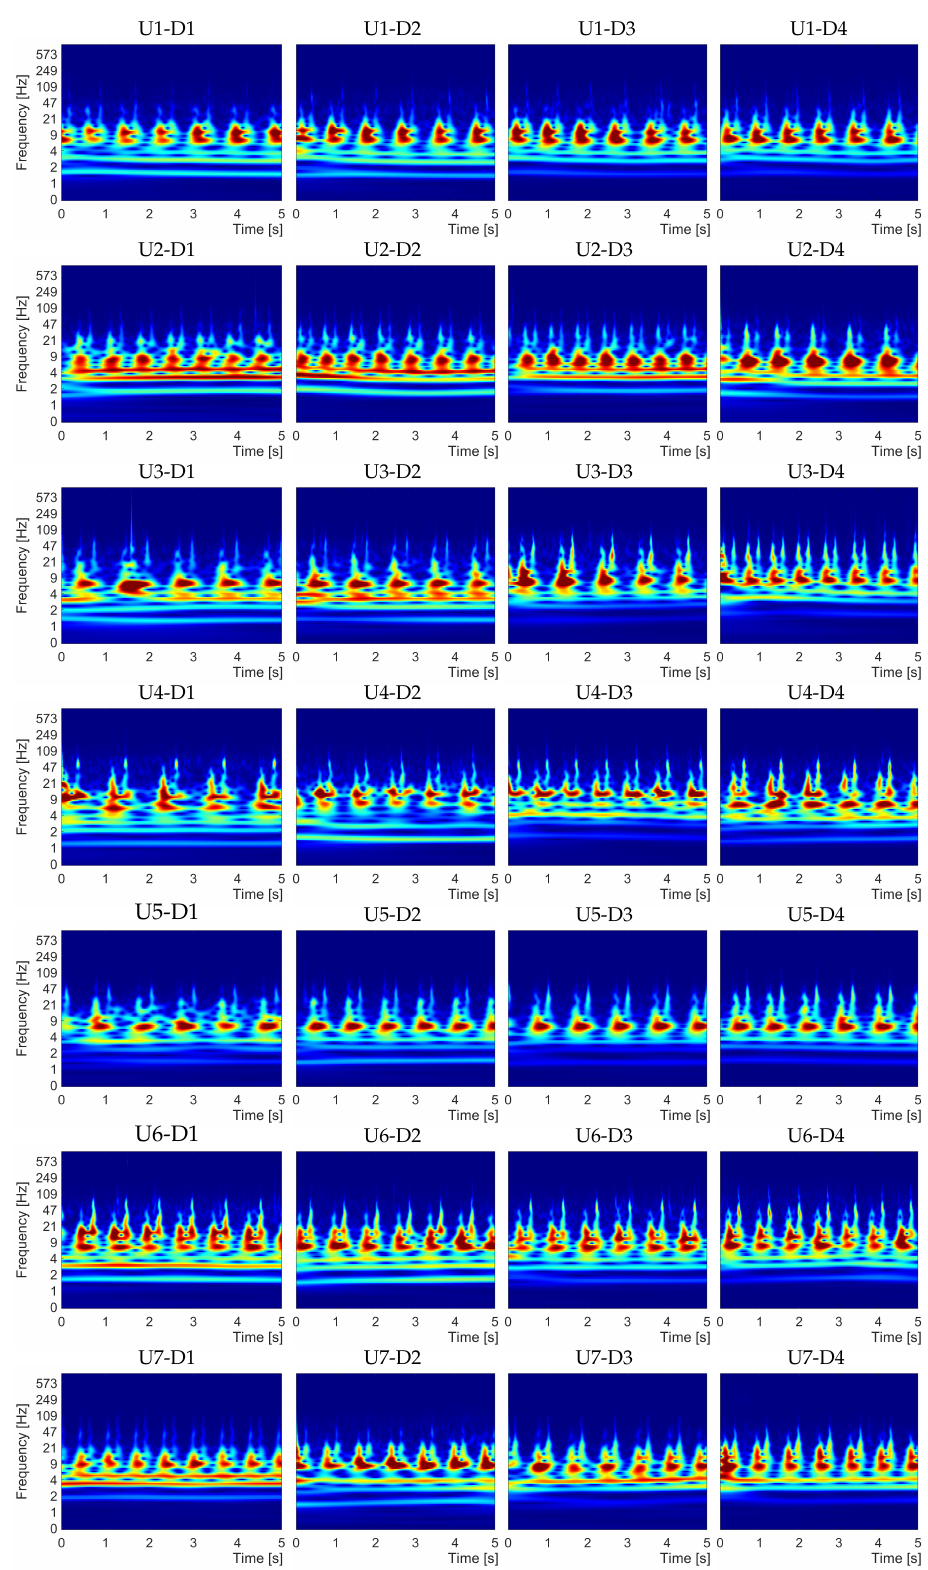
Figure 5. Examples of CWT spectral behavior of the carotid sounds for the seven users, organized as one user for each row. From the left to right, each column exhibits the CWT spectrum computed from recordings acquired by device D1, D2, D3, and